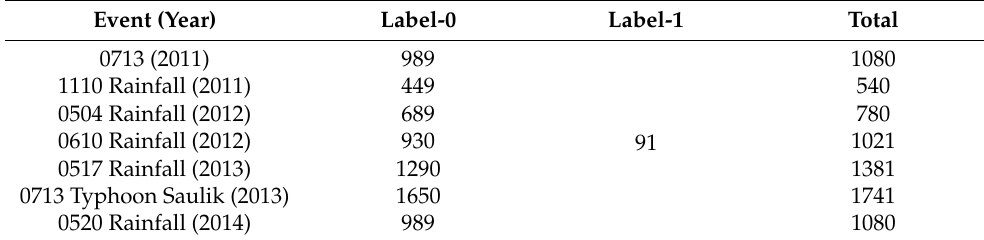
Figure 7. The illustration of labeling of debris-flow vibration signals. Table 4. Sample numbers of 45-sec interval trial. Table 4. Sample numbers of 45-s interval